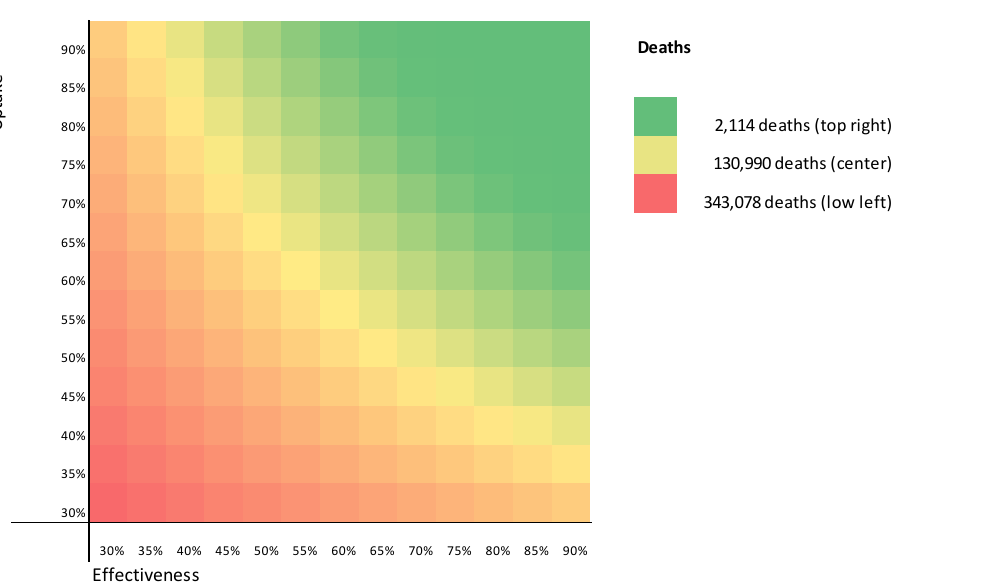
Figure 3. Heatmap of the number of COVID-19 deaths occurring after vaccination.